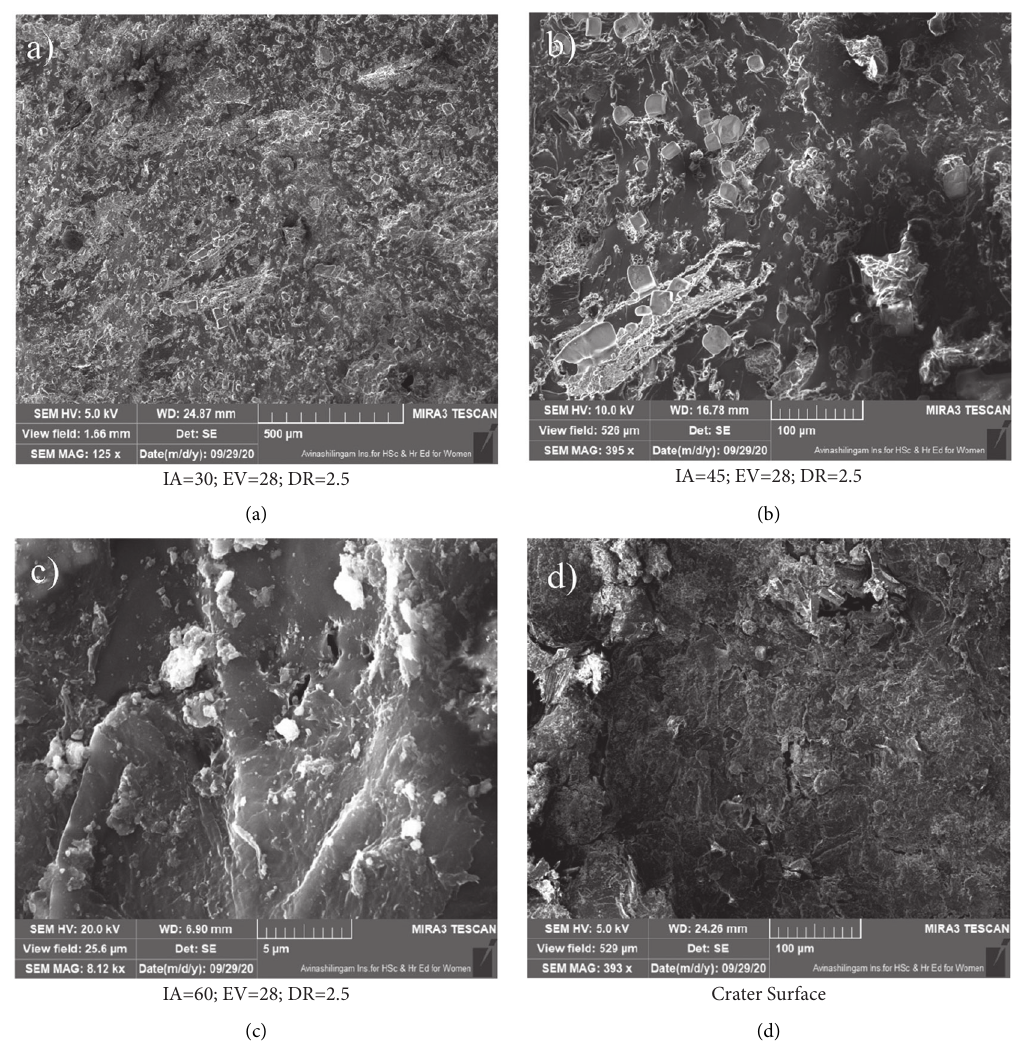
Figure 10: Surface images of the erosion sample at various working conditions. (a) IA � 30; EV � 28; DR � 2.5. (b) IA � 45; EV � 28; DR � 2.5. (c) IA � 60; EV � 28; DR � 2.5. (d) Crater